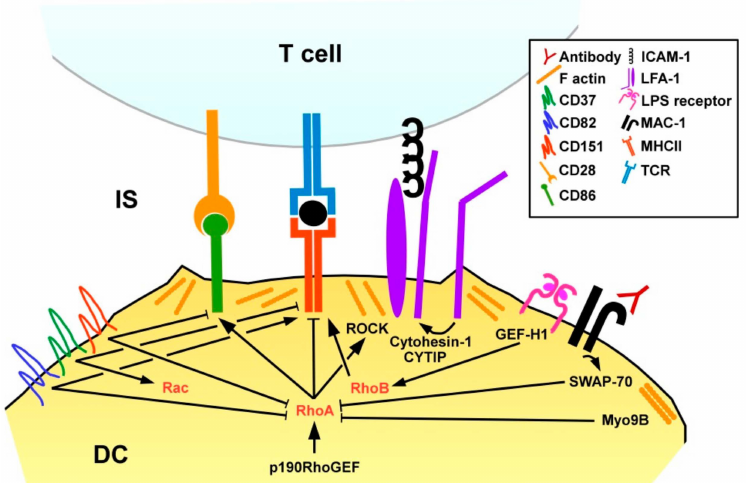
Figure 6. DC interact with T cells via the immunological synapse. Upregulated surface expression of the antigen receptor MHCII is inhibited by active RhoA, whereas RhoB may stimulate MHCII expression. RhoA is also involved in co-stimulatory expression. RhoA activity is regulated by GEF (e.g., p190RhoGEF) and GAP (e.g., SWAP-70, Myo9B), and by tetraspanins that also modulate MHCII / co-stimulator expression, presumably by other mechanisms. The duration of DC / T